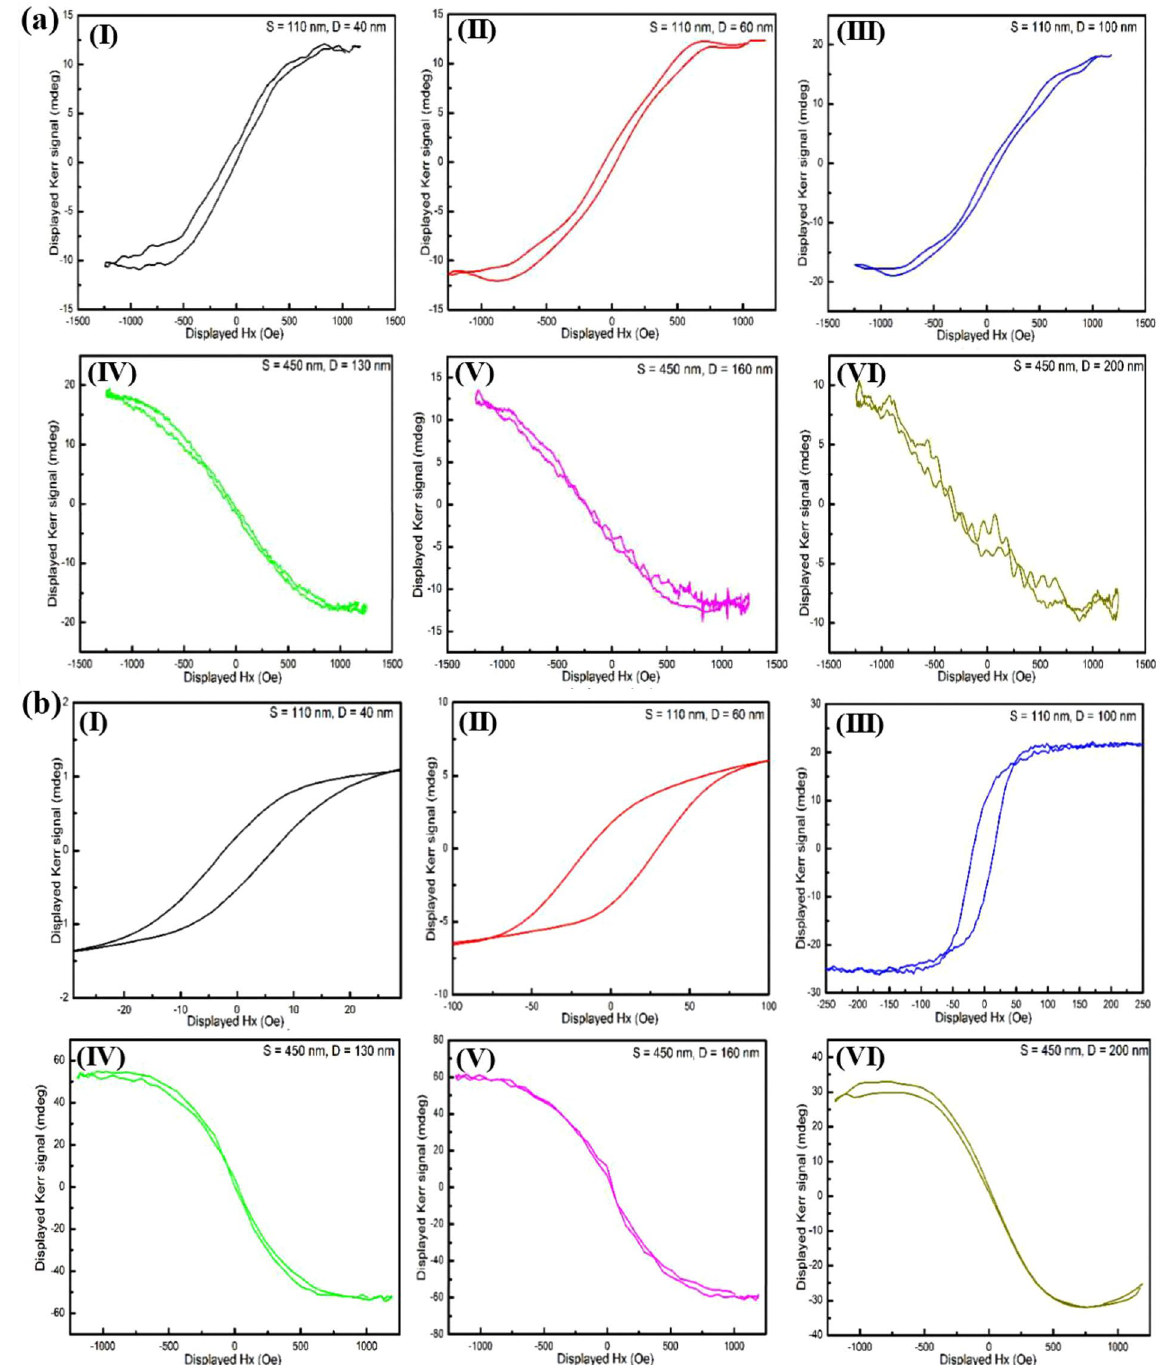
Figure 3. ( a ) P-MOKE and ( b ) L-MOKE loops of hybrid multi-layered nanoporous arrayed films deposited on six AAO templates with different geometries. (I) S = 110 nm, D = 40 nm; (II) S = 110 nm, D = 60 nm; (III) S = 110 nm, D = 100 nm; (IV) S = 450 nm, D = 130 nm; (V) S = 450 nm, D = 160 nm and (VI) S = 450 nm, D = 200